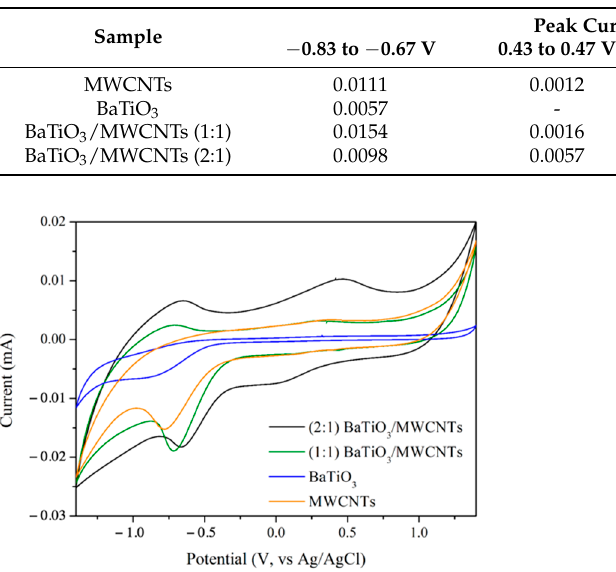
Figure 6. Cyclic voltammogram of MWCNTs, BaTiO 3 , BaTiO 3 /MWCNT composite (1:1)-based electrode, and BaTiO 3 /MWCNT composite (2:1)-based electrode in 500 µM citric acid at a scan rate of 100.0 mV/s.